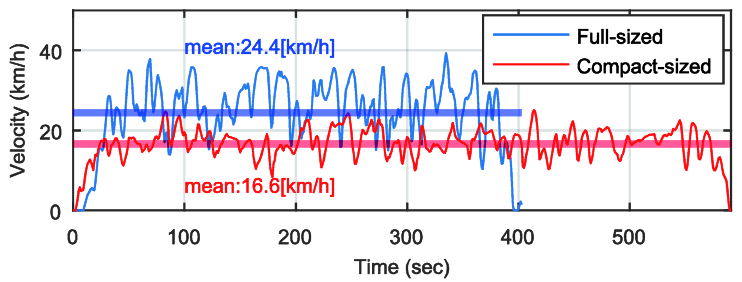
Figure 12. Vehicle velocities for localization tests.